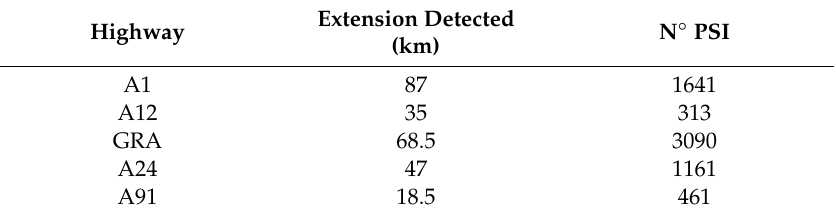
Figure 3. ( a ) Displacement map PSI Sentinel-1 for Rome metropolitan ( b ) Displacement map PSI for highway network, as background orthophoto Rome. The white insets highlight the 3-area selected for further analysis. Table 2. Number of PSI target contained by each